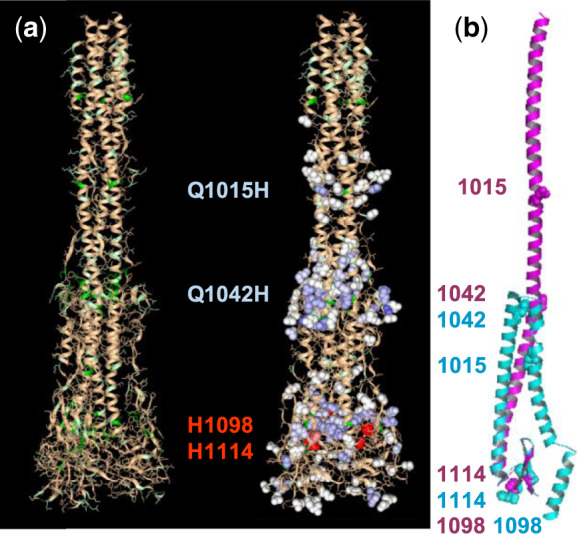
Coronavirus in the pKa web server. (a) The post-fusion structure of MHV A59 (6b3o) with ionizable group burial (left) and pKa calculations around selected centers (right, color codes Fig. 1c). (b) Segments of pre- (3jcl, cyan) and post-fusion (6b3o, magenta) MHV A59 structures. Residues of interest are indicated throughout